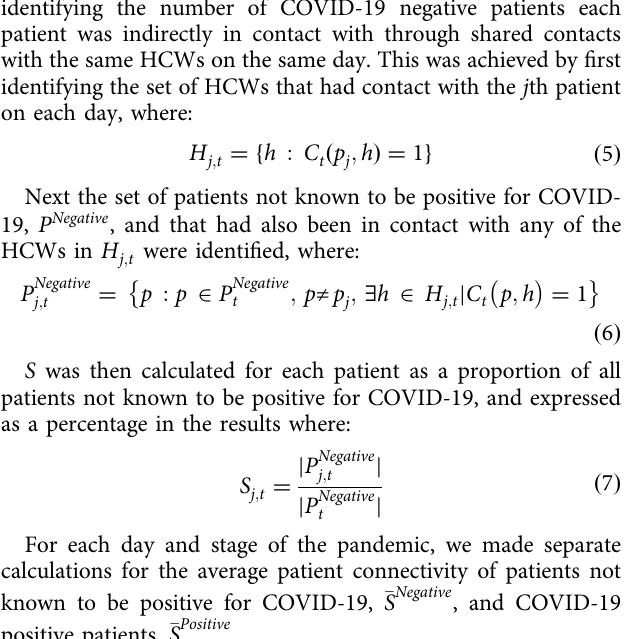
algorithm with a hierarchical greedy modularity maximization- based approach 34 . To check the robustness of clusters we also identi fi ed clusters using the leading eigenvalue and walktrap algorithms. All clustering analyses were implemented using the R package igraph v1.2.7 35